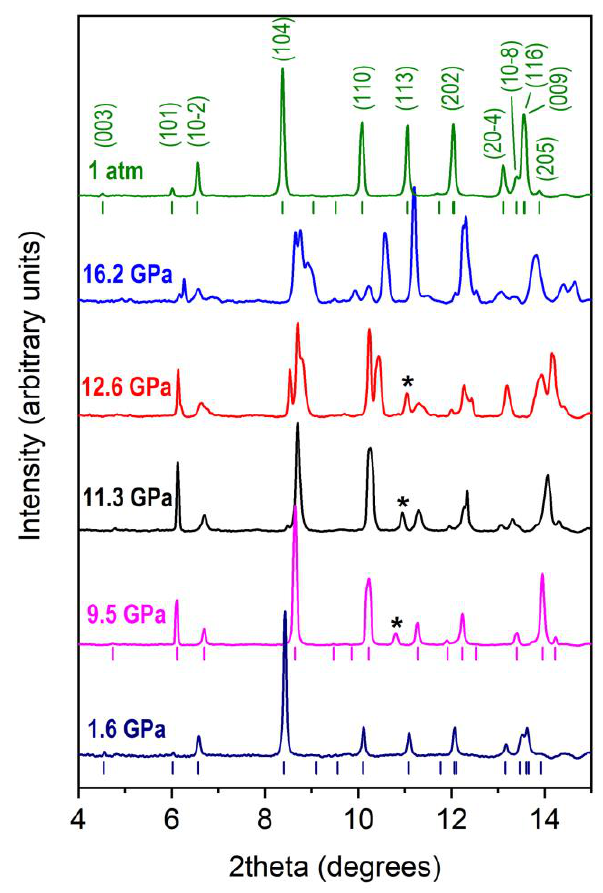
Figure 2. Selected powder XRD patterns of Ca 1.08(6) Mg 0.24(2) Fe 0.64(4) Mn 0.04(1) (CO 3 ) 2 ankerite from experiments. Backgrounds have been subtracted. Reflections of the initial dolomite-type structure are indicated as vertical marks and labelled. The diffraction peak assigned to the (210) reflection of the molecular CO 2 –I solid phase is denoted with an asterisk (*). Synchrotron radiation wavelength was 0.4246 Å . Table 1. Experimentally determined lattice parameters ( a and c ) and unit cell volume of R - 3 ̅